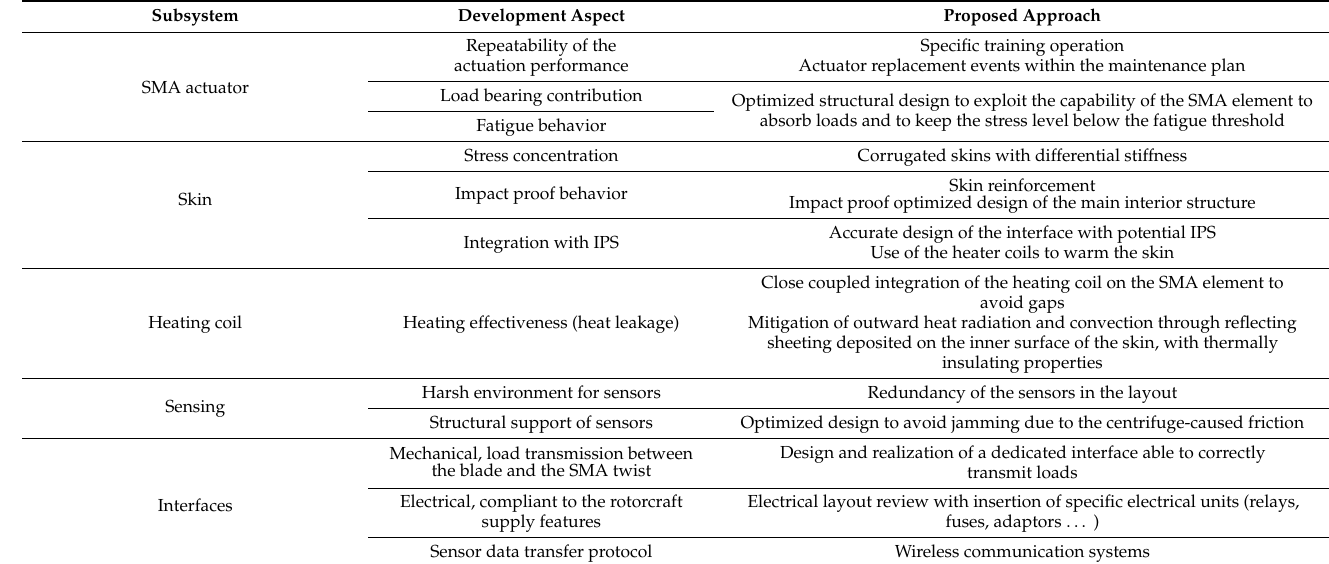
Table 4. Adaptive twist blade, impacted development aspects, and proposed